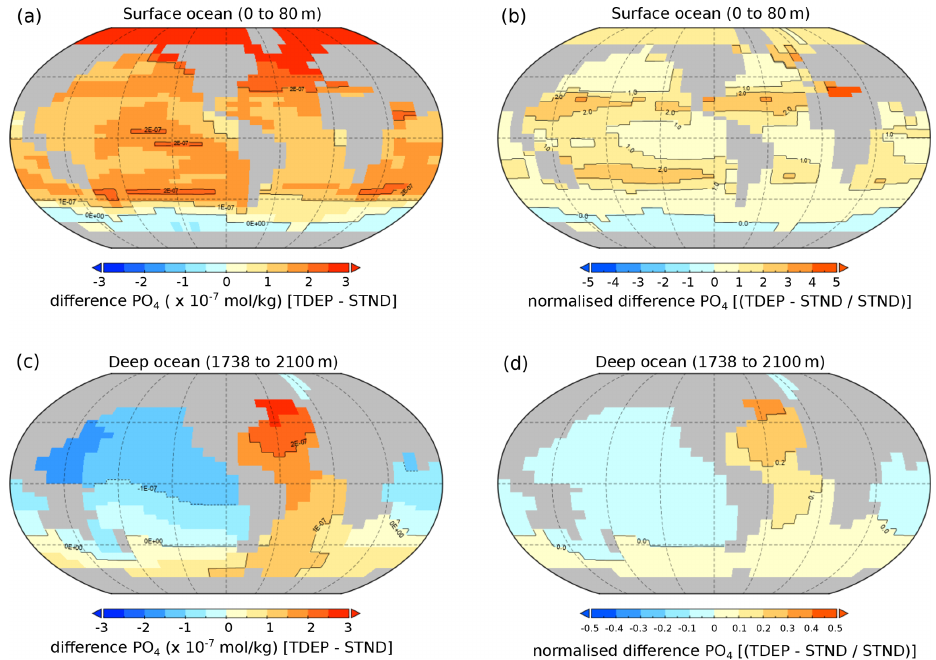
Figure 8. Difference in PO 4 concentration for best-fit TDEP compared to STND, (a, b) surface waters (0 to 80m), and (c, d) deep waters (1738 to 2100m). (a, c) Absolute difference (molkg − 1 ) and (b, d) normalised difference. All are the present day; note the scale difference in terms of the normalised difference between surface and deep water. STND is the standard model, and TDEP is the temperature-dependent model.